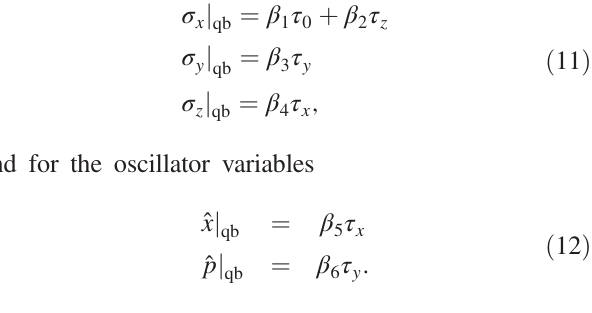
FIG. 7. Coefficients β of the operator projections in the qubit i space, obtained by numerical diagonalization (solid lines) and 0 . 5 , 1, and 1.5. from the analytical approximation to fourth order in g (dashed m ¼ lines). The value of t is fixed here to 20 ℏ ω m